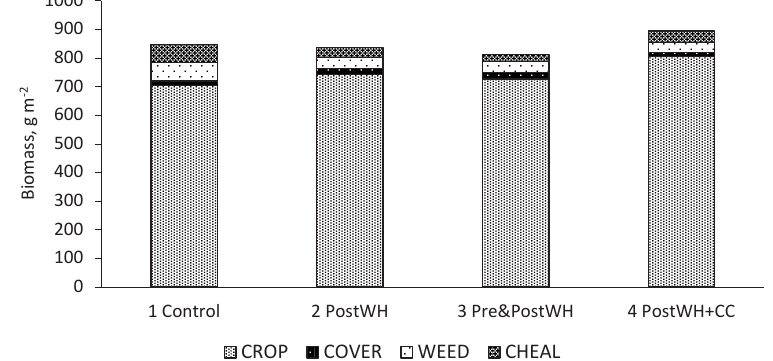
Fig. 3. Effect of weed harrowing (WH) treatments on the biomass shares between different plant groups at harvest time of spring wheat (“CROP”) in 2020. “COVER” represents the pooled biomass of undersown clover-grass mixture in all treatments and additionally the cover crop honey flower (“CC” in Treatment 4). “WEED” represents all other weed species except C. album